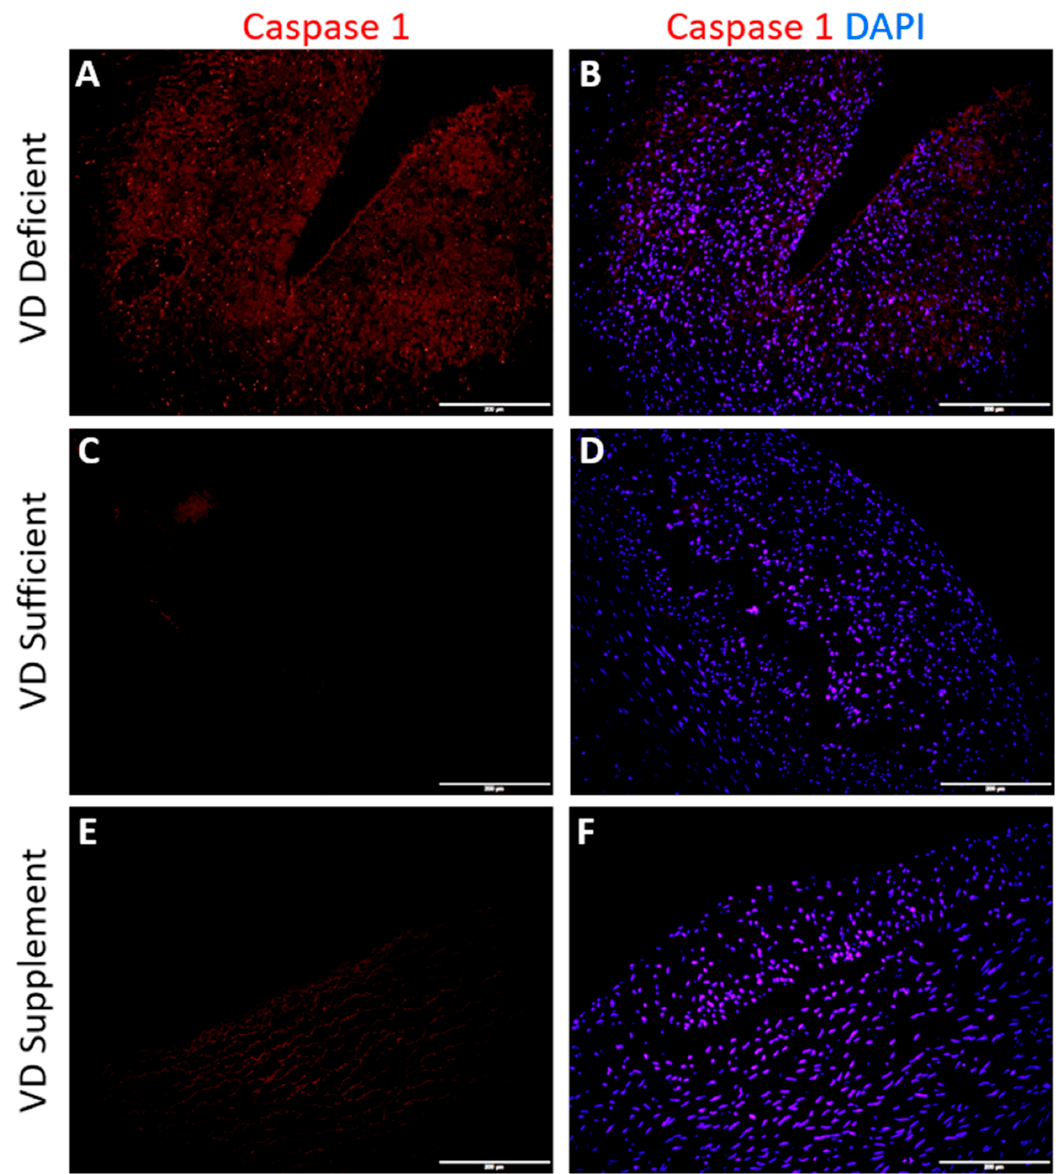
Figure 3. Immunofluorescence for Caspase-1 in a coronary artery with angioplasty. Caspase-1 (panels A , C , and E ) in vitamin D deficient (VDDef), sufficient, (VDSuff), and supplemented (VDSupp) coronary artery; caspase-1 with DAPI (panels B , D , and F ); 4 ′ ,6-diamidino-2-phenylindole (DAPI).All images were scanned at 200 𝜇𝑚 scale.